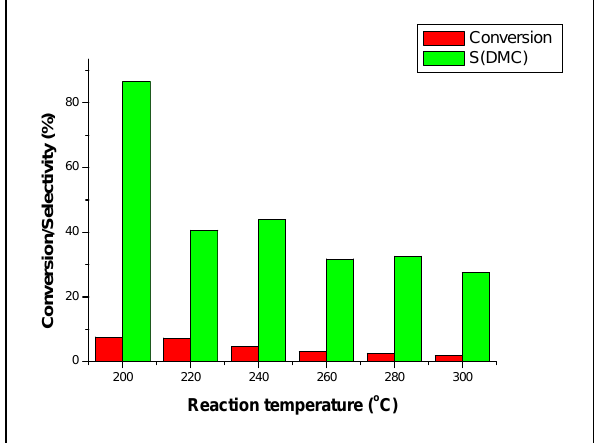
Figure 5. The dependence of the conversion and product selectivity on reaction PW O Reaction conditions: MWHSV = 3.25 h -1 ; molar ratio temperature over Co 1.5 12 40. CH OH /CO = 3 2